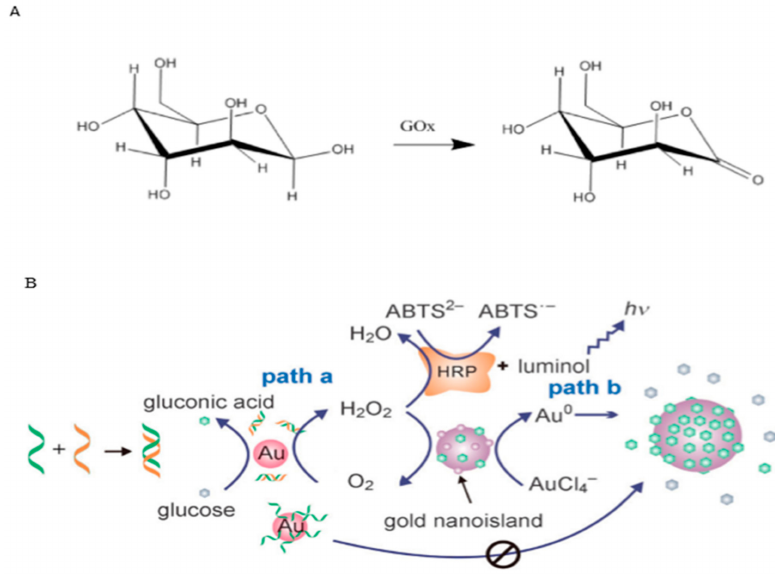
Figure 44. ( A ) Glucose togluconolactone oxidation catalyzed by glucose oxidase (GOx). ( B ) Application to the sensor to find DNA hybridization of GOx-like catalytic activity of Au NPs. The Au NPs (red) will catalyze glucose oxidation and produce peroxide under the present pattern. This can be used in the subsequent oxidation of ABTS in a horseradish peroxidose (HRP) colour (path A ). Peroxide production also catalyzes AuCl 4 to Au 0 reduction, which increases the size of Au NPs (path b). ( A ) Replicated with authorisation from reference [293] Copyright The Biochemical Society. ( B ) Reproduced with permission from reference [294], Copyright 2011,